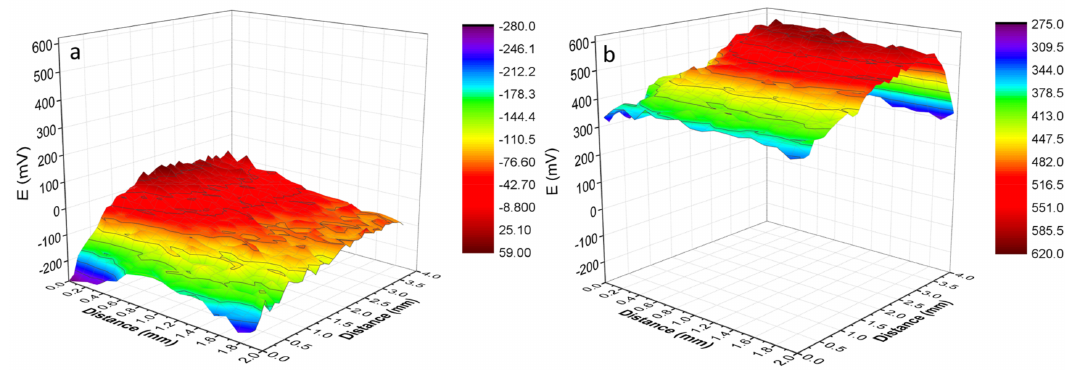
Figure 7. Scanning Kelvin probe (SKP) surface potential maps of Ni–P ( a ) and Ni–P–G ( b ) in an area of 2 mm × 4 mm exposed to